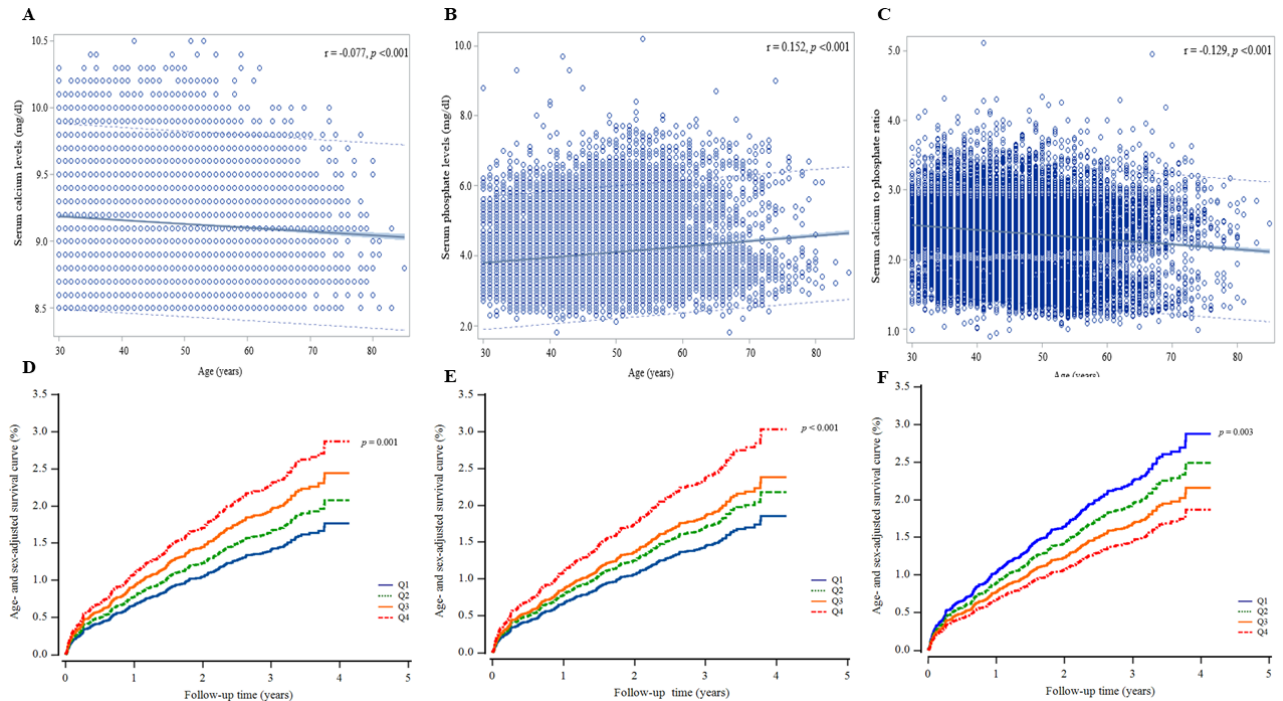
Figure 3. Trends in serum mineral levels according to age and Cox regression survival curves; serum calcium ( A , D ), phosphate ( B , E ), and calcium-to-phosphate ratio ( C , F ).